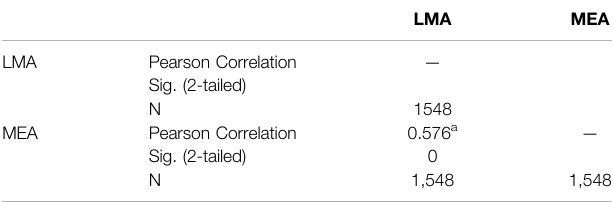
TABLE 2 | Descriptive statistics of mathematics anxiety. TABLE 3 | Correlation between LMA and